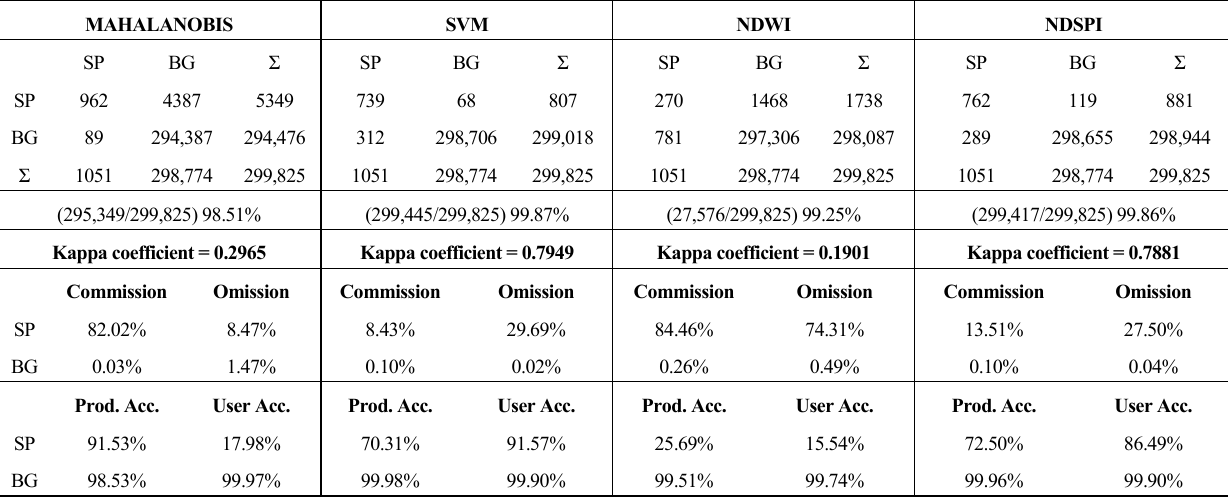
Table 1. Confusion matrix of the studied methods, where columns are the ground truth and rows represent the classification results. SP, swimming pools; BG,